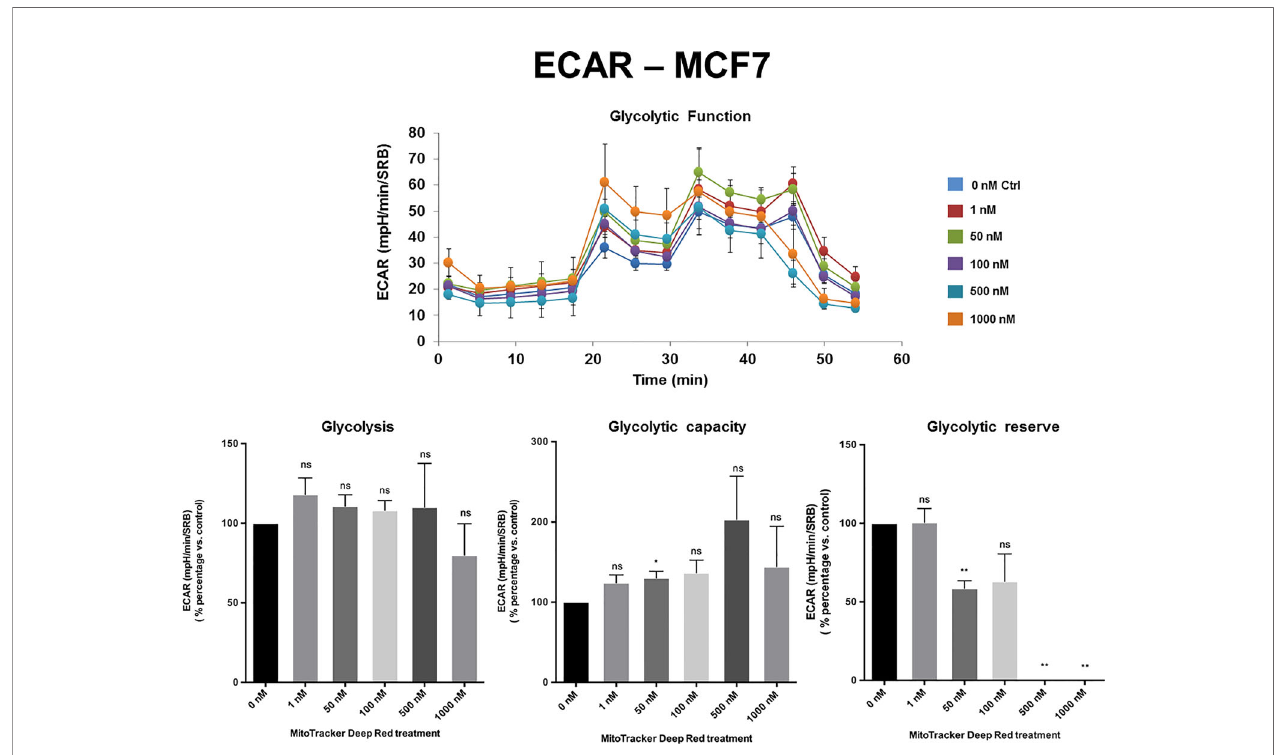
FIGURE 4 | MTDR has no effect on glycolysis in MCF7 cells. A representative Seahorse tracing is shown, with bar graphs highlighting the quantitative, dose- dependent effects of MTDR on glycolysis, glycolytic capacity and glycolytic reserve. Note that MTDR has no signi fi cant effect on glycolysis, at concentrations up to 1 m M. The statistical test used was a one-tail unpaired